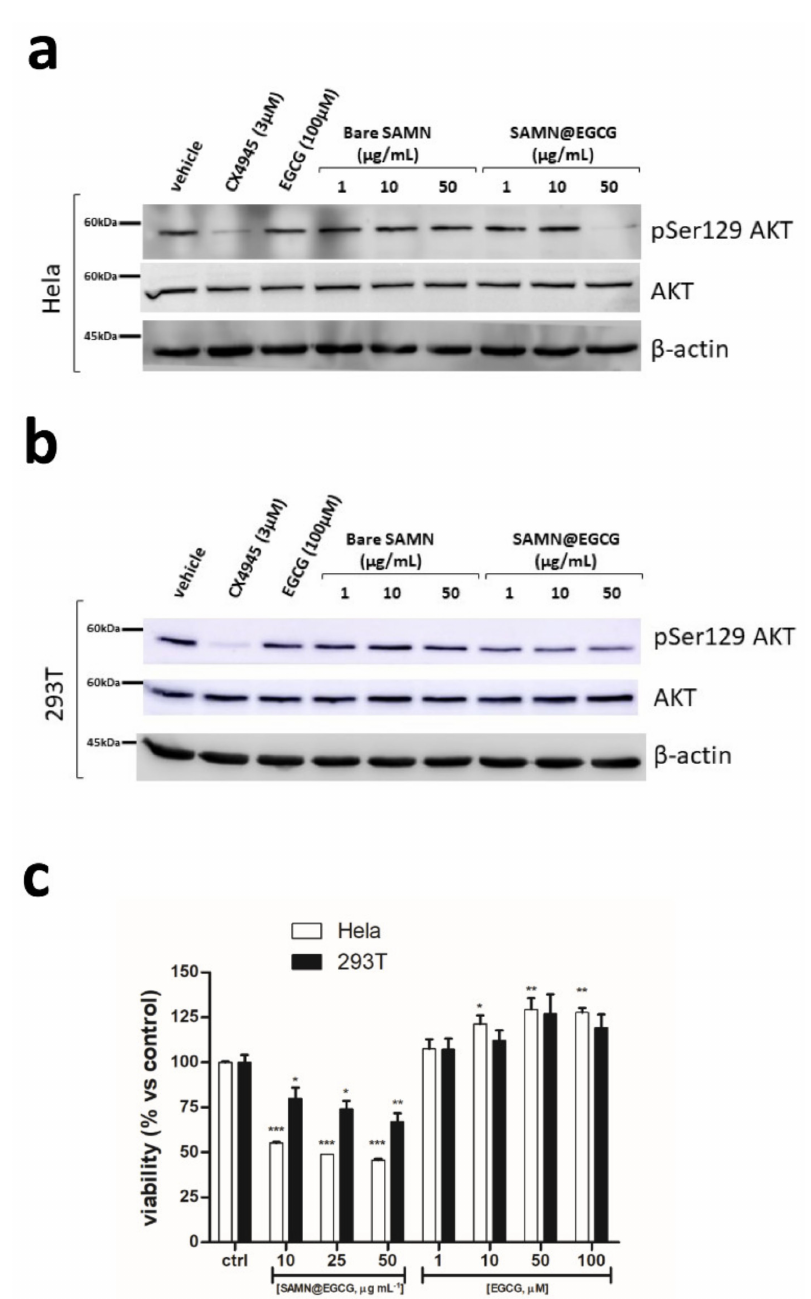
Figure 4. Enhanced cellular targeting and endogenous protein kinase CK2 inhibition by SAMN@EGCG nanocarriers in human cell cultures. Total cell lysates (15 µ g of proteins/sample) from ( a ) Hela cells and ( b ) 293T cells treated for 16 h with the indicated treatments were immunoblotted with antibodies against both phospho-specific (S129) and total AKT. β -actin was used as loading control. Represen- tative WBs of 3 independent experiments are shown. ( c ) Cytotoxicity evaluation of SAMN@EGCG nanohybrid. The viability of HeLa (white bars) and 293T (black bars) cells was measured by MTT assays after 24 h of treatment with the indicated concentrations of SAMN@EGCG and free soluble EGCG, respectively. The means ± SD of 3 independent experiments are reported; * p < 0.05, ** p < 0.01 and *** p < 0.001 compared to control (1-way ANOVA using Bonferroni’s